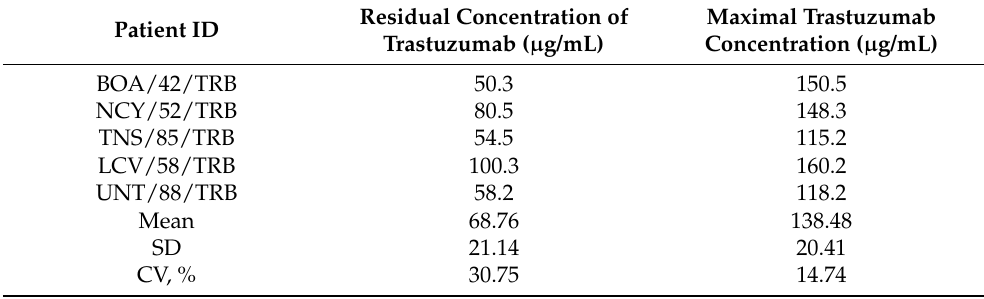
Table 4. Residual and maximal concentration ( µ g/mL) of trastuzumab in breast cancer